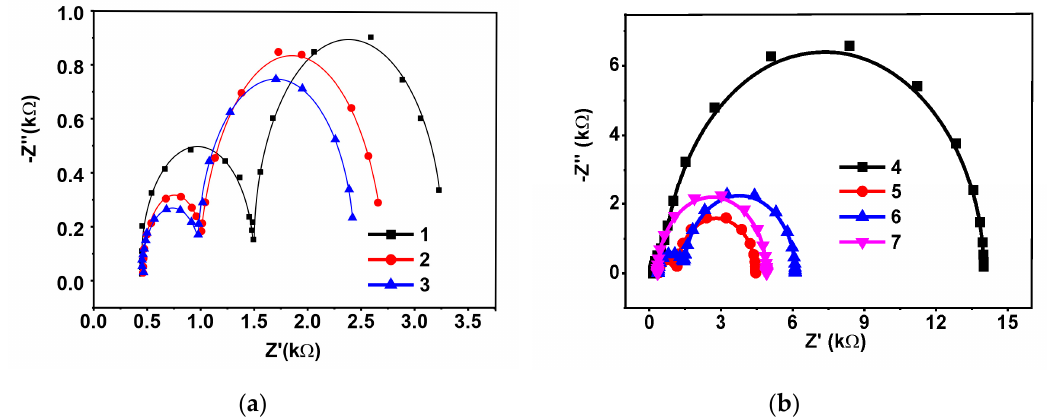
Figure 4. The Nyquist diagram of the impedance spectra recorded on the GCE covered with the CB / chitosan and the OLA- cone / aptamer (1:2). ( a ) Immobilization on the CB / chitosan film; ( b ) Immobilization onto PDDA film. Surface layer content: 1-CB / chitosan; 2-CB / chitosan–OLA- cone / aptamer (1:2); 3-CB / chitosan–OLA- cone / aptamer (1:2)–KANA 1.0 nM; 4-OLA- cone ; 5-OLA- cone –PDDA; 6-OLA- cone –PDDA–aptamer; 7-OLA- cone –PDDA–aptamer–KANA 10 nM. Measurements were performed in the presence of 0.01 M K 3 [Fe(CN) 6 ] and 0.01 M K 4 [Fe(CN) 6 ]. Frequency range 0.04 Hz–100 kHz, amplitude 5